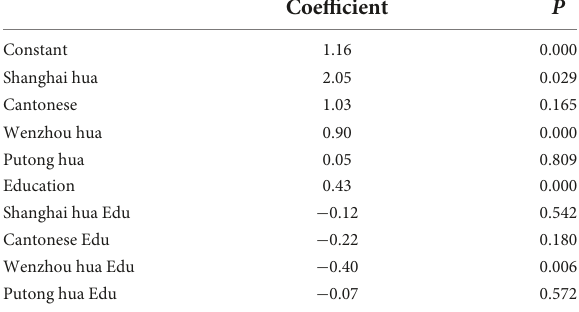
TABLE 9 Moderation effect of social motivation.